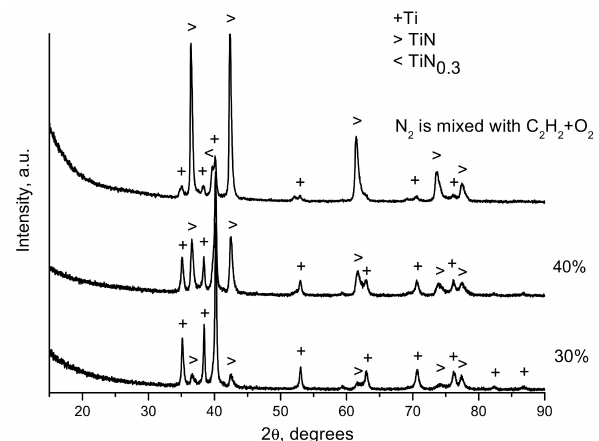
Figure 15. XRD patterns of deposits obtained from titanium at k = 1.1 and explosive charges of 30%, 40% and 60% using nitrogen as a carrier gas; during deposition with an explosive charge of 60%, nitrogen (33 vol. %) was introduced into the mixture of O 2 + C 2 H 2 (reprinted from [29], Copyright (2015), with permission from